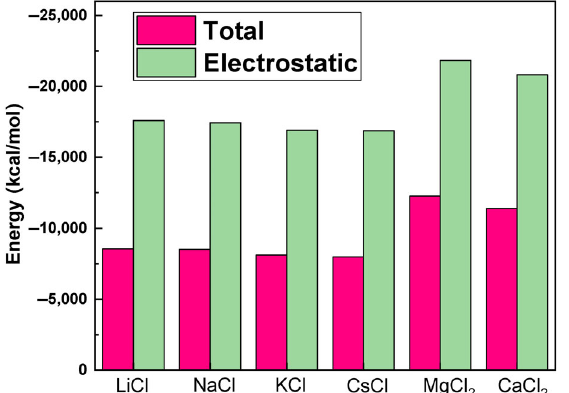
Fig. 10 Total energy of the unit cell and its electrostatic interaction energy after kinetic